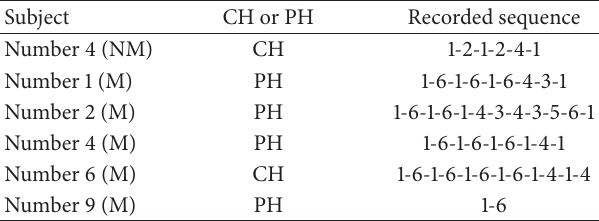
Table 6: Table of chord sequences identified by the complete and partial successful subjects during the harmonization task.